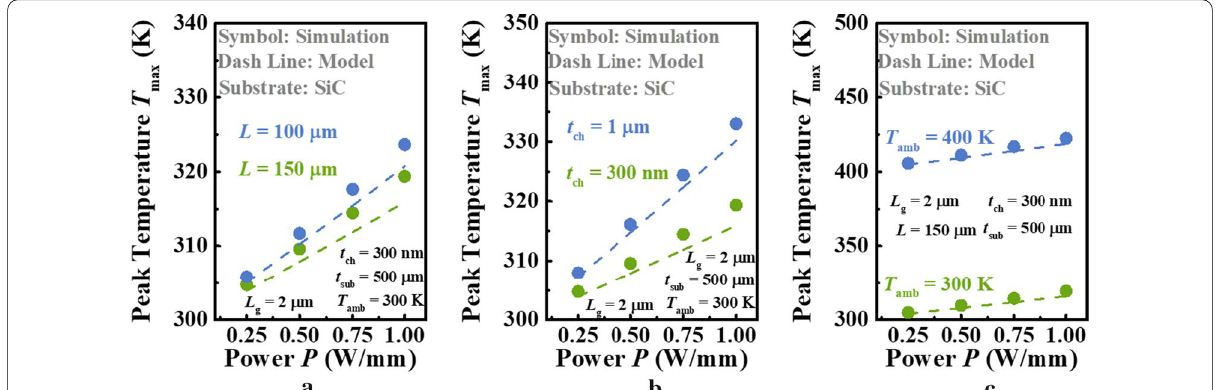
Fig. 4 Dependence of T max of Ga 2 O 3 MOSFETs with SiC substrate on a the length of device L , b the thickness of Ga 2 O 3 layer t ch , and c ambient temperature T amb at different power P . Symbols and lines denote the results of proposed model and simulation,